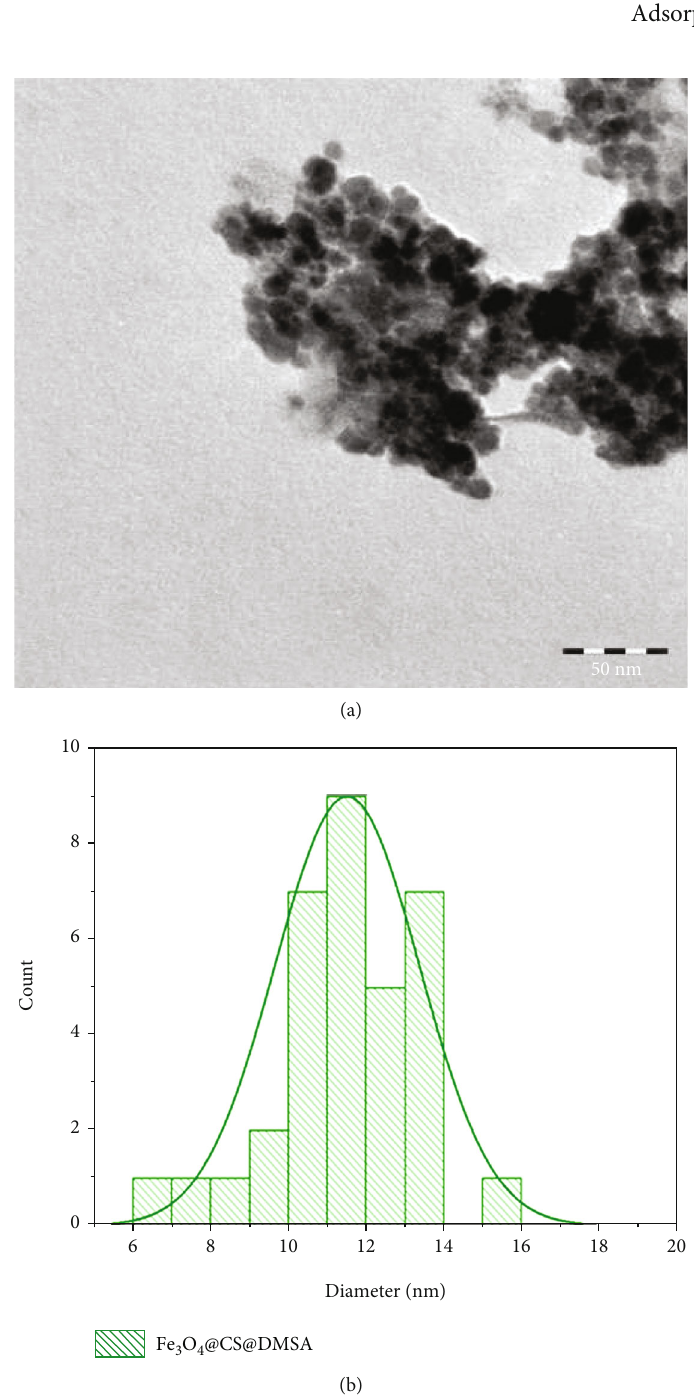
Figure 3: (a) TEM image and (b) particle size distribution plots of Fe